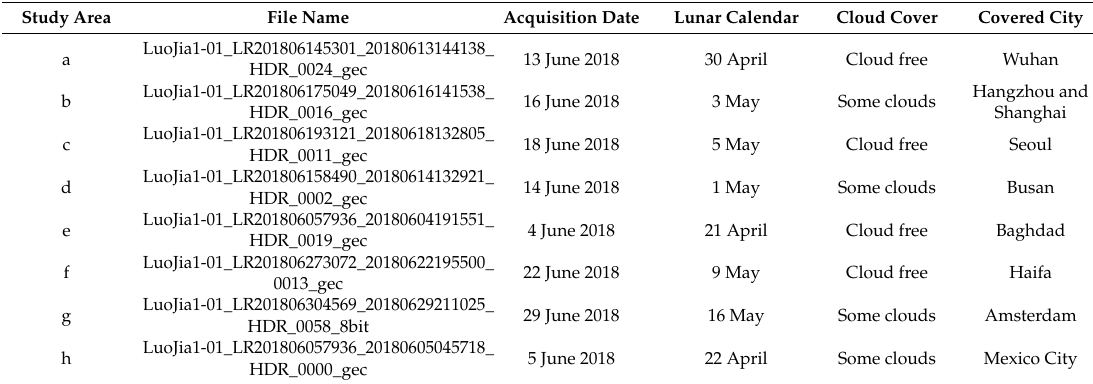
Table 2. The description of experiment data used in this study.